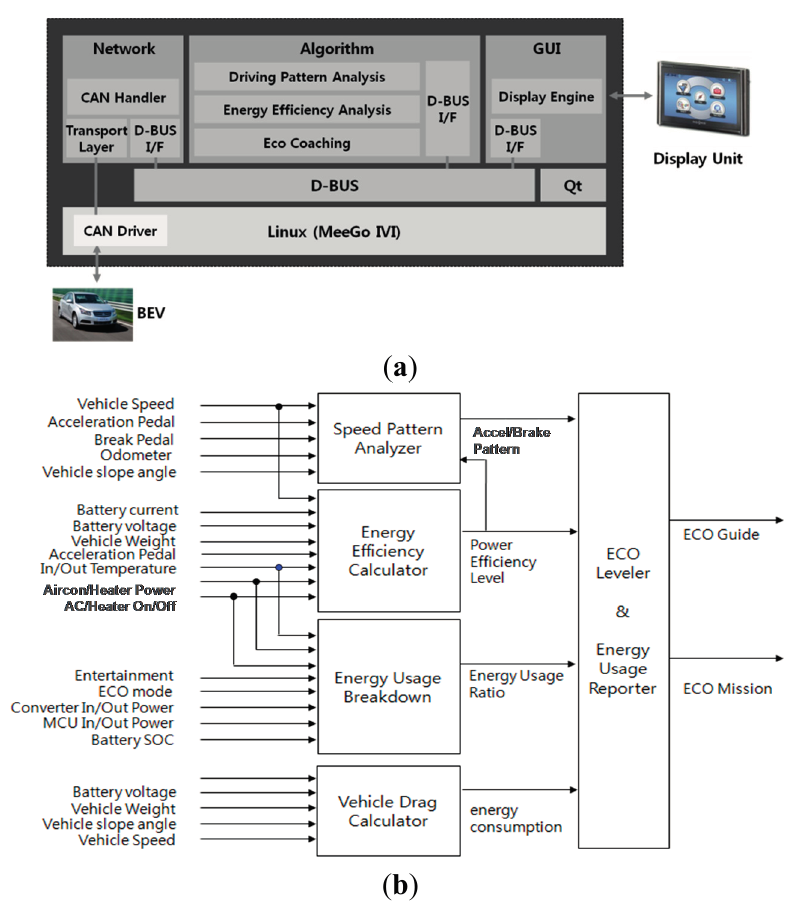
Figure 5. ( a ) Real-time embedded system; ( b ) Block diagram for